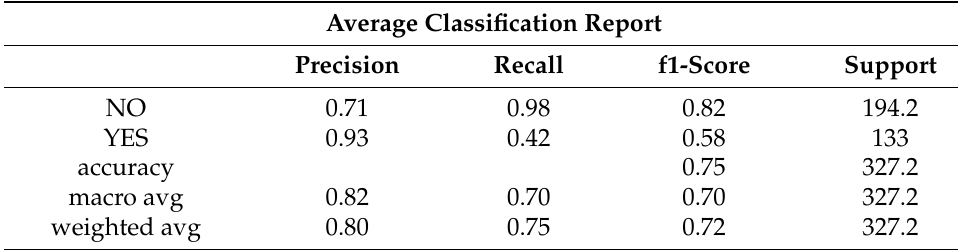
Table 1. Classification report after 5 repetition of model training and testing.